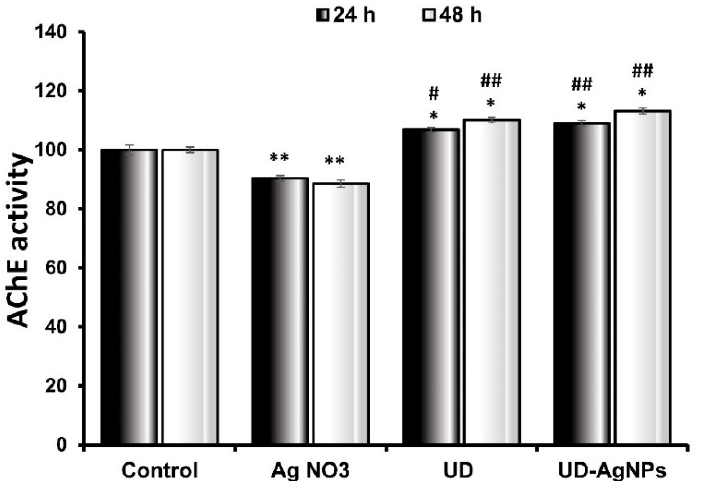
Figure 8. Acetylcholinesterase activity in Drosophila third instar larvae exposed to AgNO 3 , UD, and UD-AgNPs for 24 h and 48 h. The data are shown as the mean ± SD ( n = 3). Significance is indicated as * p < 0.05 and ** p < 0.01 vs. control. # is ascribed as significance at p < 0.05 and ## p < 0.01 compared with AgNO 3 . AgNO 3 = silver nitrate, UD = Urtica dioica , and UD-AgNPs = biosynthesized silver nanoparticles of Urtica dioica .